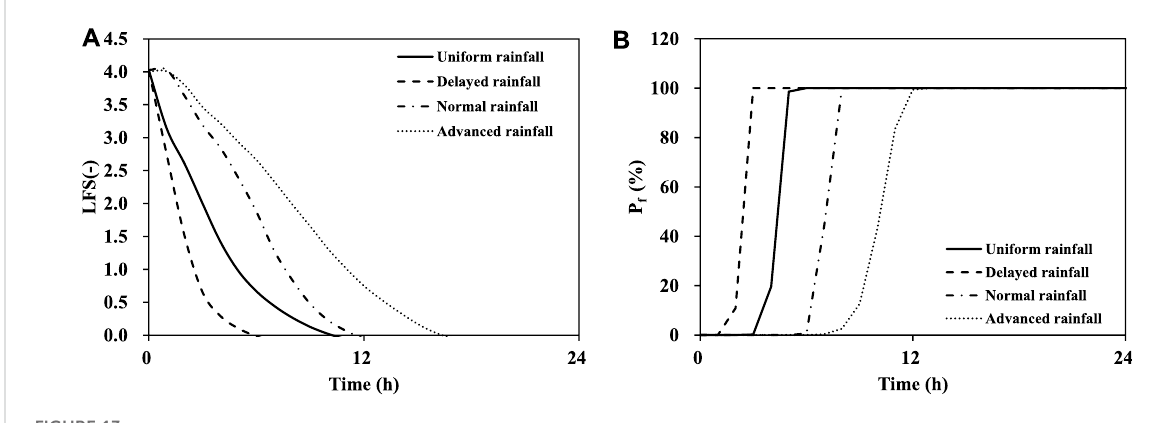
FIGURE 13 Result of (A) slope stability analysis and (B) probability of failure under four rainfall